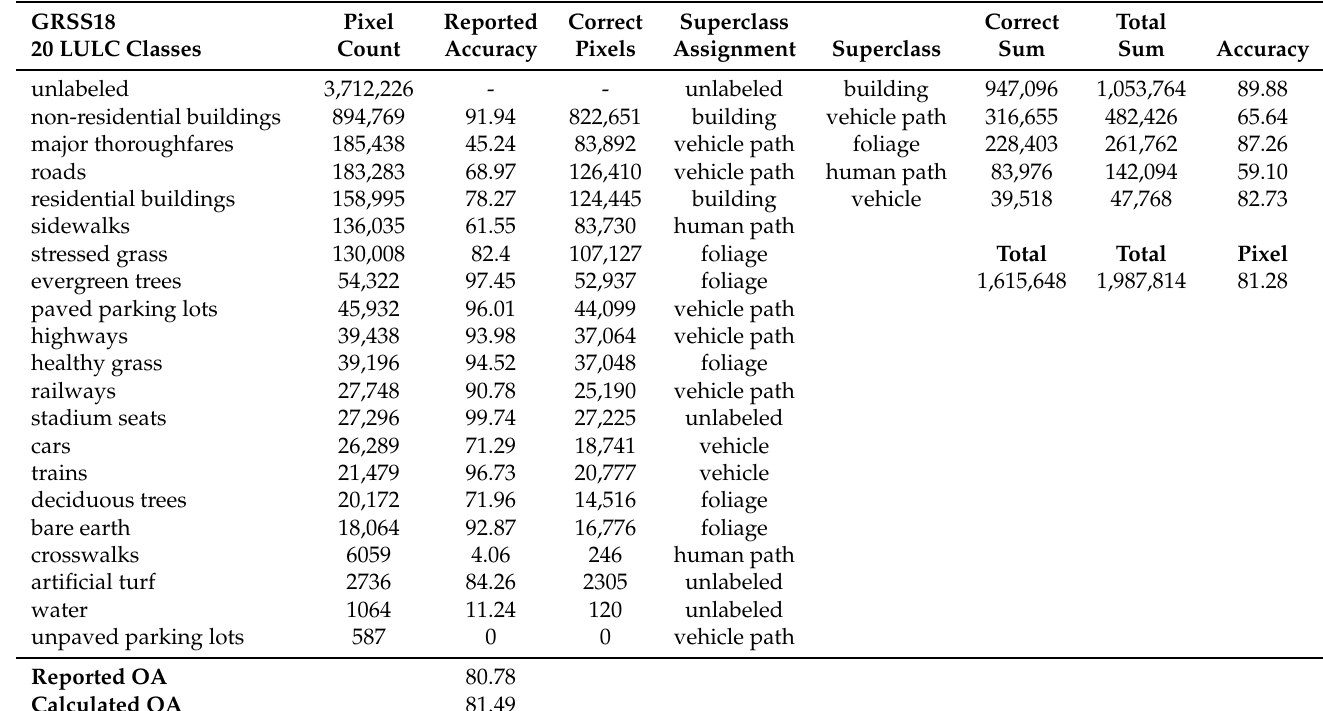
Figure A1. Training, validation and test set split of the semantic pixel map. Yellow lines denote set boundaries. Top left section represents the training set. Bottom right section denotes testing set. Center section denotes the validation set. Table A3. Example translation of previous work which predicts semantic pixel maps on the GRSS18 data set using the original 20 LULC classes. Below, the per class accuracies as reported by Xu et al. [10] are used. First, the class distributions of the 20 LULC classes are calculated over the entire GRSS18 labeled area. Second, for each class, the total number of correct pixels are calculated by multiplying the total pixel count by the reported accuracy. Then, for each of the superclasses, the sums of both the correct and total pixels are calculated. Finally, the per superclass accuracies and pixel accuracy are calculated from the summations. Note that the reported pixel accuracy against the 20 LULC classes is also provided at the bottom. This value is recalculated based on the known class distribution as a check for fairness, it is off by less than